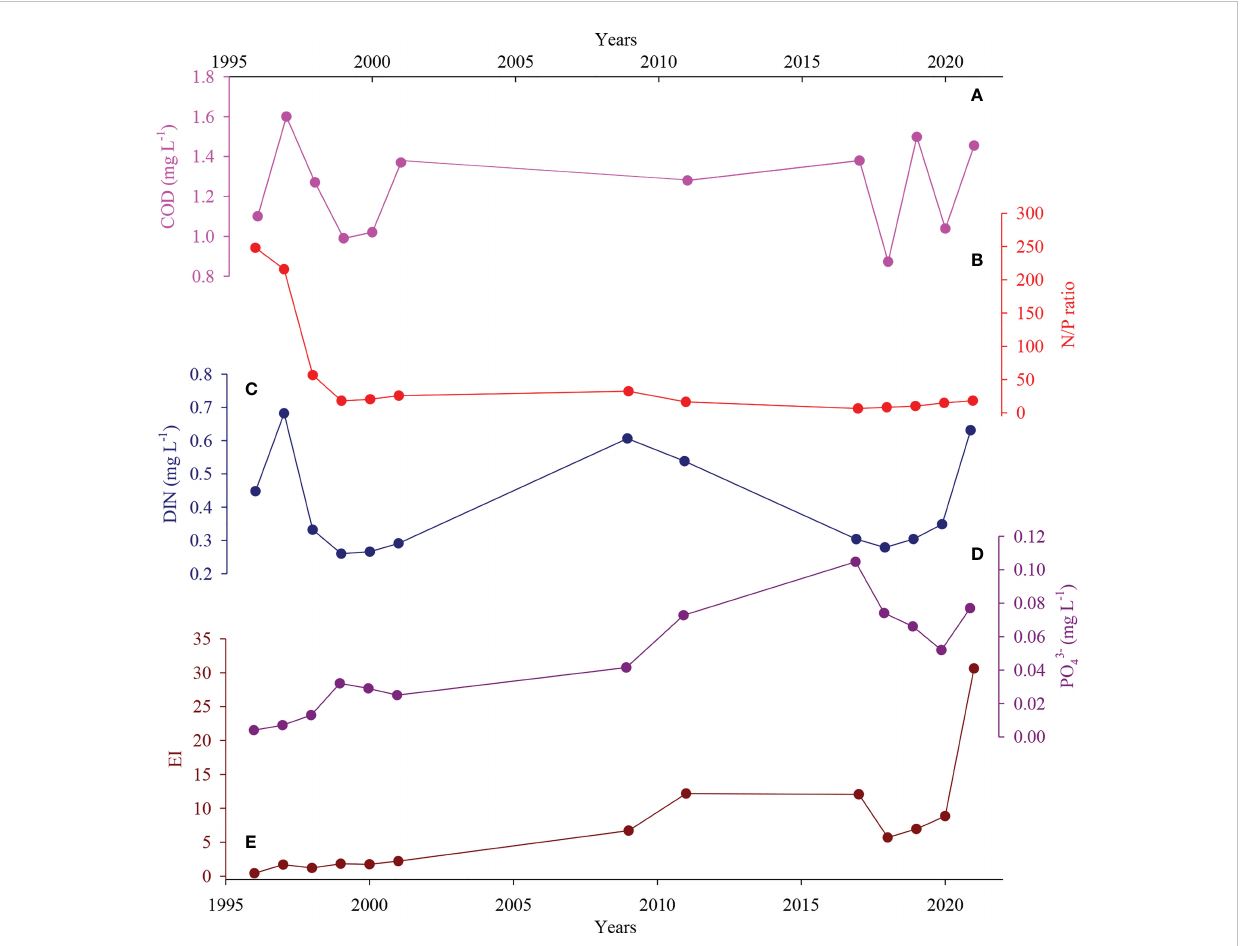
FIGURE 5 Annual variations of eutrophication index, N/P ratio, nutrients (DIN and PO 43- ) and COD in Zhanjiang Bay over the past 30 years. The data for 1996 and 1997 were obtained from Cheng et al., 2012; the data of 1998-2001 obtained from Lu et al., 2002; the data of 2009 obtained from Zhang et al., 2012; the data of 2011 obtained from Shi et al.,